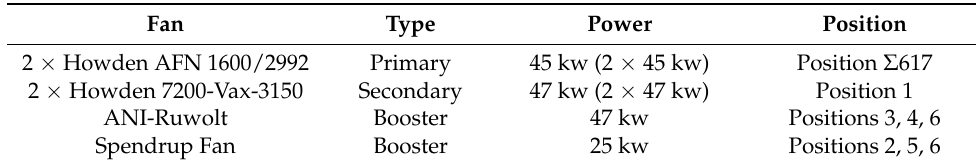
Table 2. Selected fans and their positions in the network.